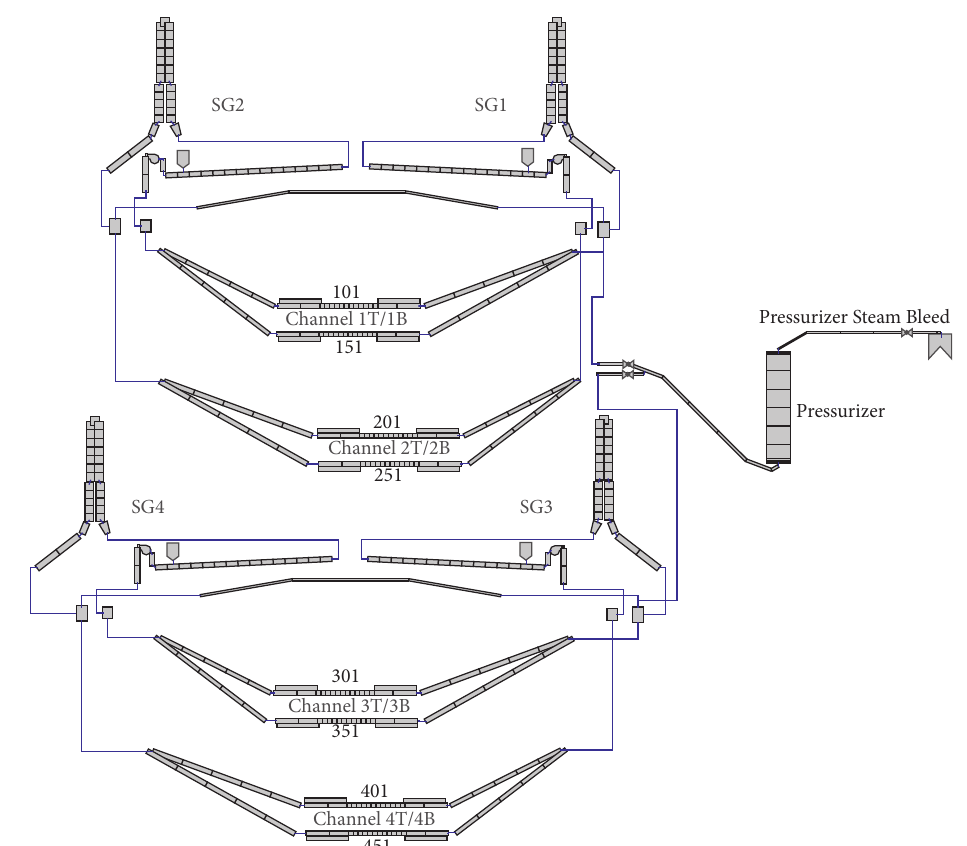
Figure 8: Thermal-hydraulic nodalization of 900 MW CANDU primary side.